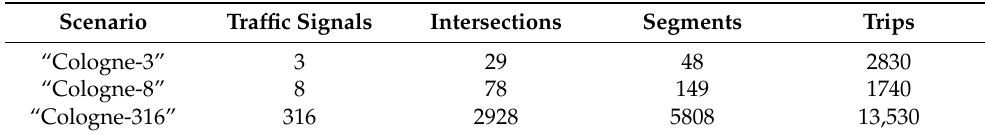
Table 1. Simulation scenario parameters.